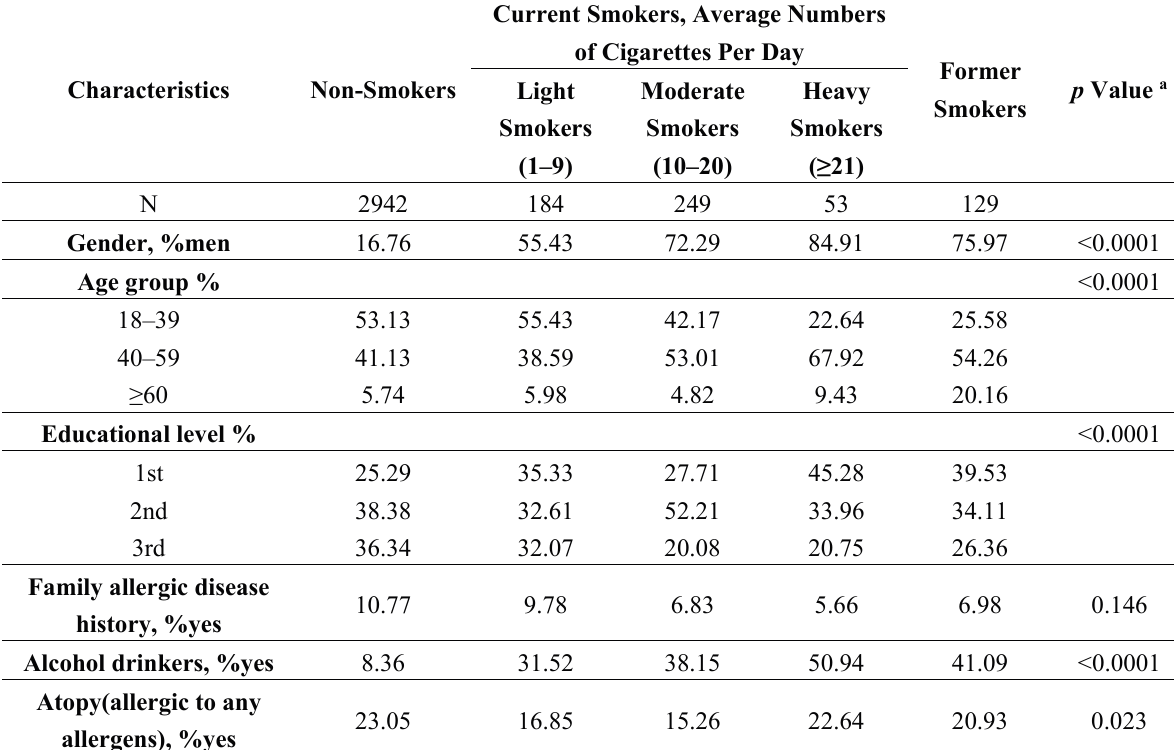
Table 1. Demographic and lifestyle characteristics of study subjects on the smoking status.